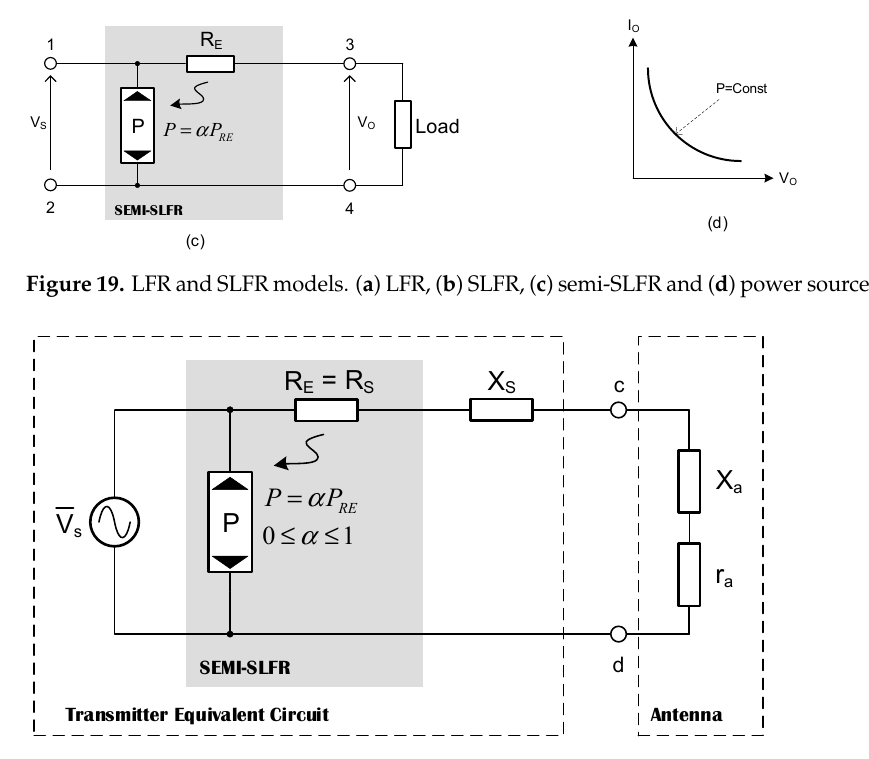
Figure 20. Simplified equivalent circuit of transmission system based on the semi-SLFR concept.